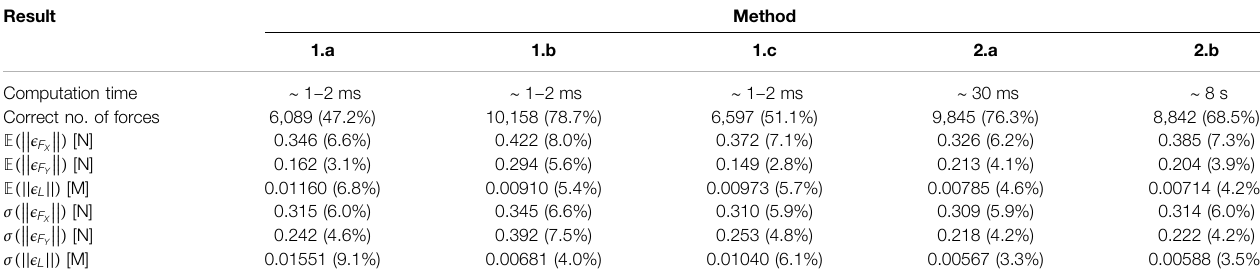
TABLE 2 | Summary of force estimation results illustrating estimated force numbers and errors on magnitudes and locations. E (|| · ||) and σ (|| ϵ · ||) represent the mean and standard deviation of the absolute value of the error, respectively.